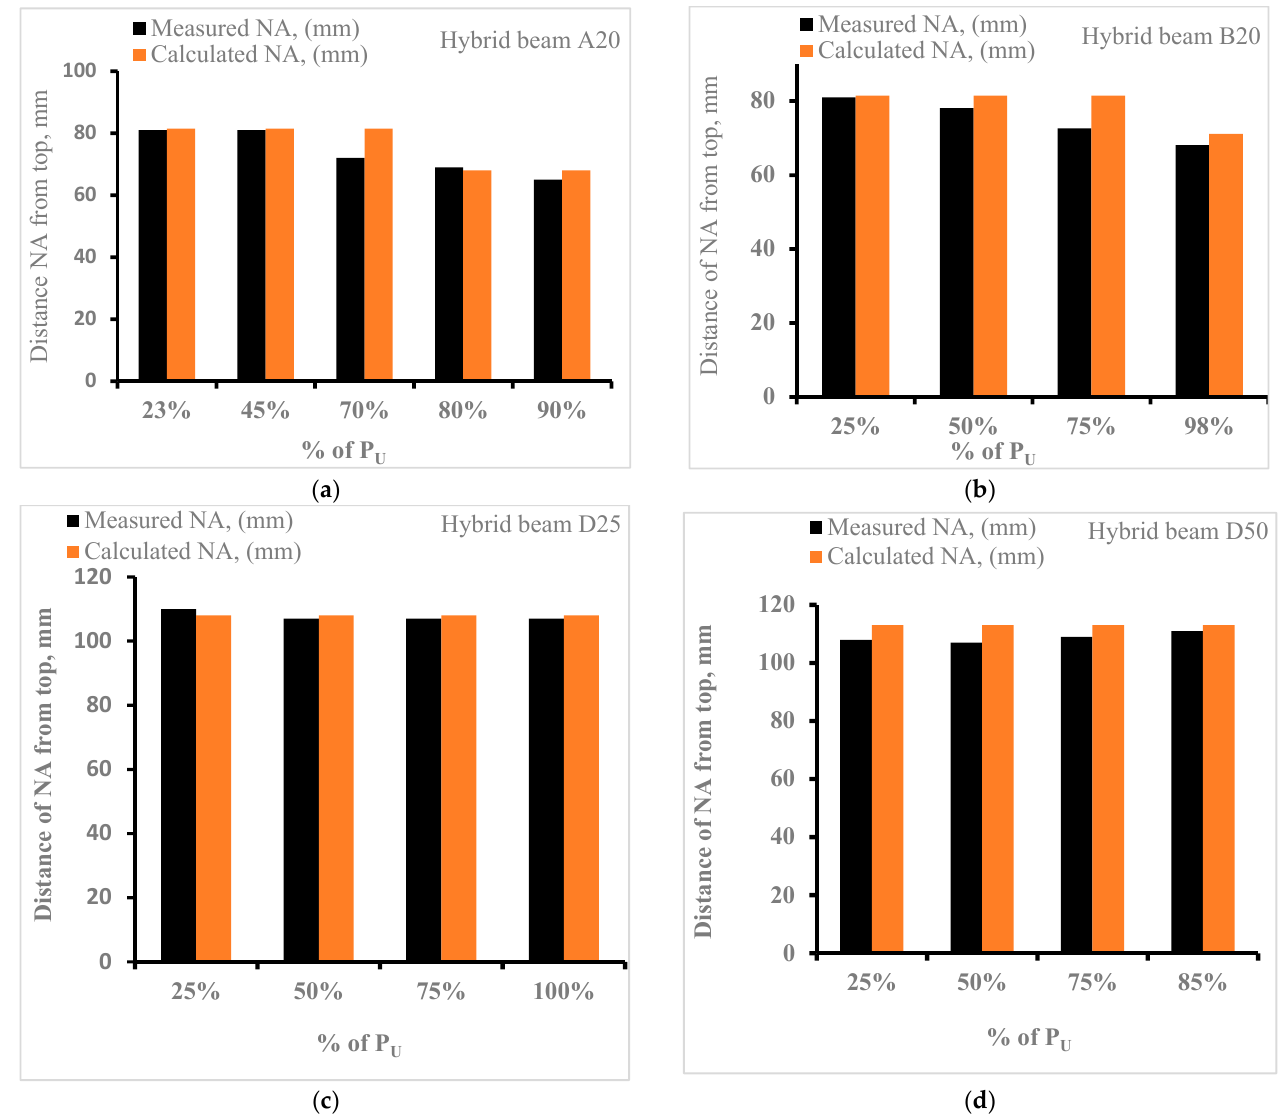
Figure 13. Measured and calculated distance of neutral axis (X) from top: ( a ) beam A20, ( b ) beam B20, ( c ) beam D25, and ( d ) beam D50.